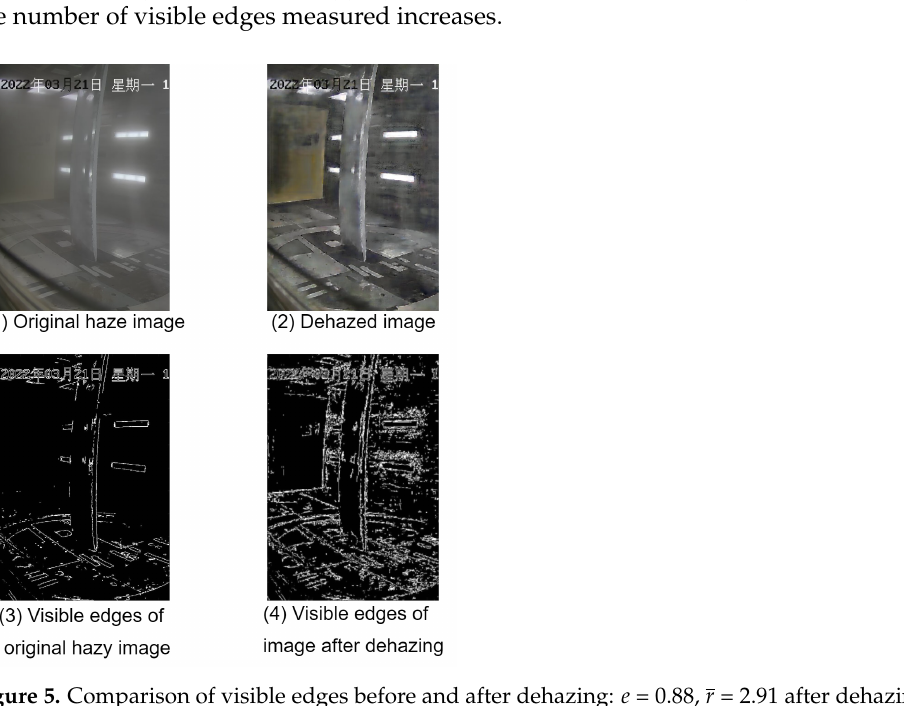
Figure 5. Comparison of visible edges before and after dehazing: e = 0.88, r = 2.91 after